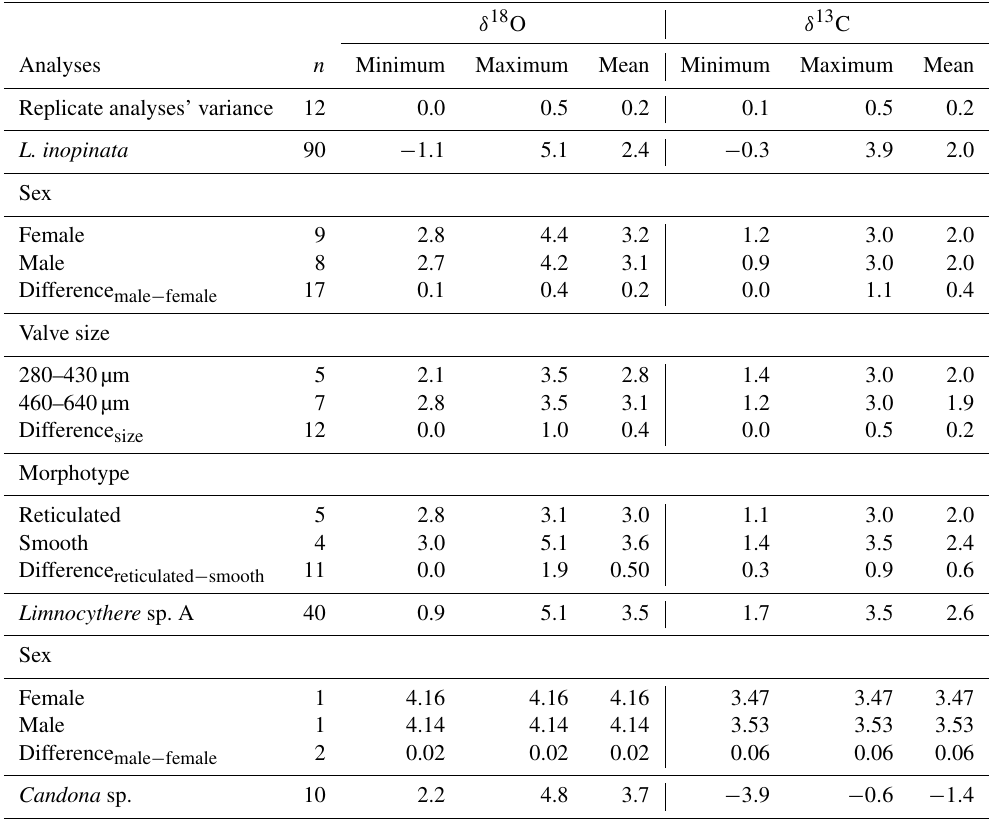
Table 1. Isotopic variability (minimum, maximum and mean) between different species, sex, valve size and reticulation intensity from the ICDP Ahlat Ridge cores. For six samples, replicate analyses were performed with valves showing no differentiating characteristics. Calculated variance is represented by the difference of these replicate analyses. Analyses comparing sex, valve size and reticulation intensity were measured from the same stratigraphic horizon. n represents the number of